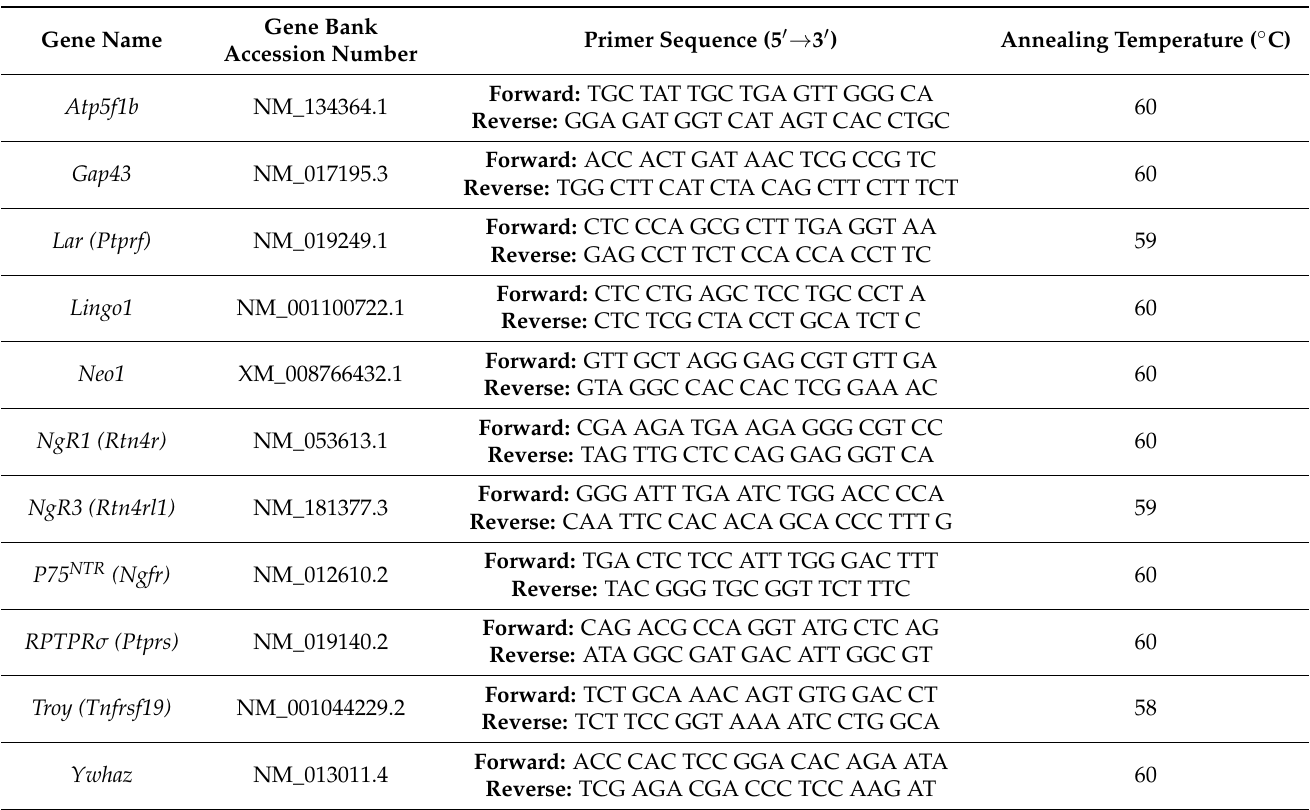
Table 3. Primer (forward and reverse) sequences, annealing temperatures and NCBI accession